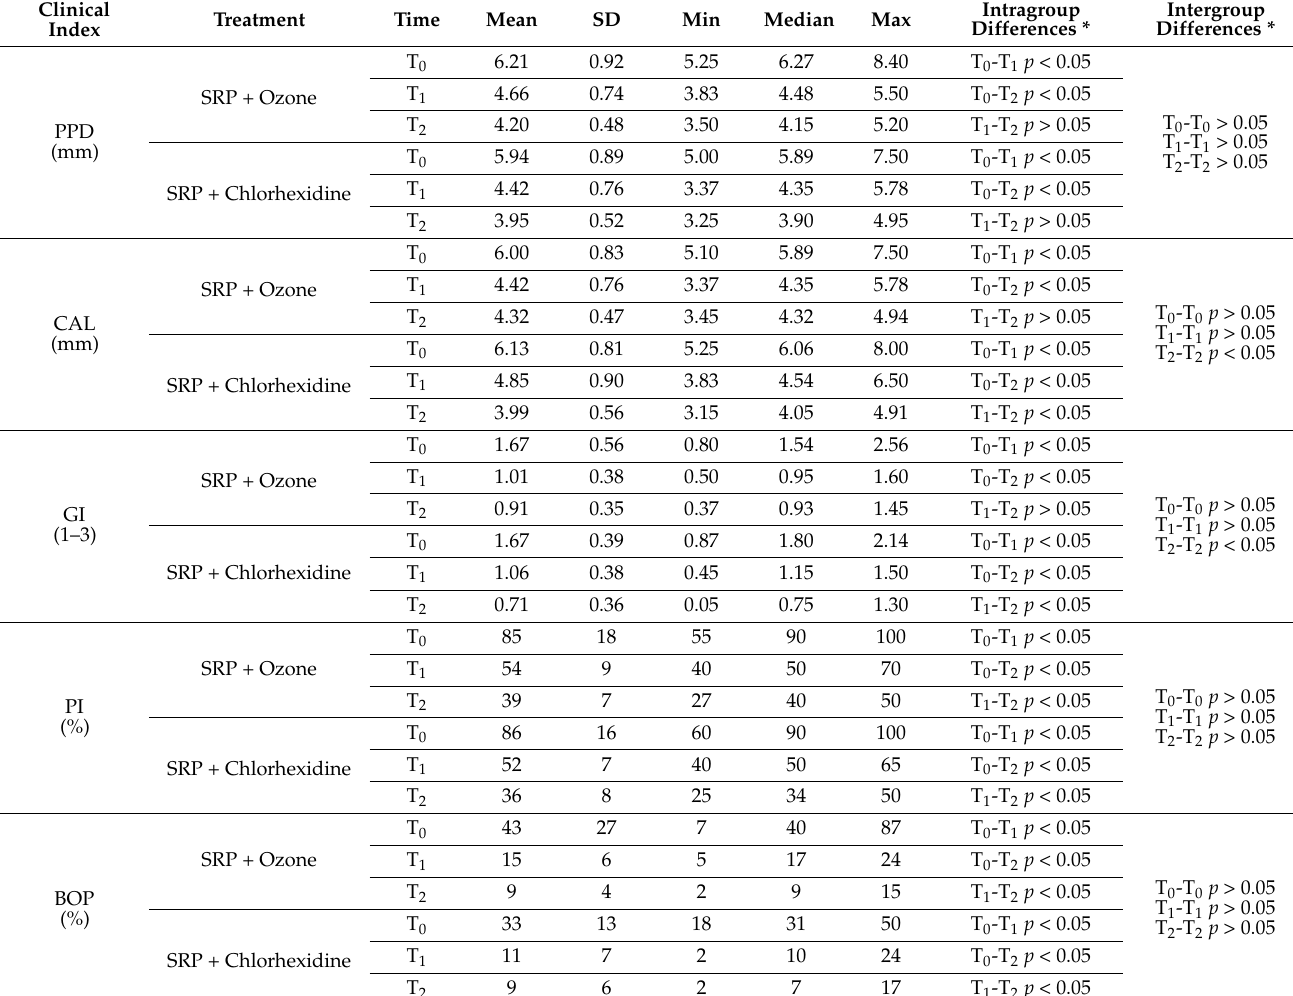
Table 3. Descriptive statistics (mean, SD, minimum value, median, maximum value) of the clinical indexes assessed in the study: PPD, CAL, GI, PI,